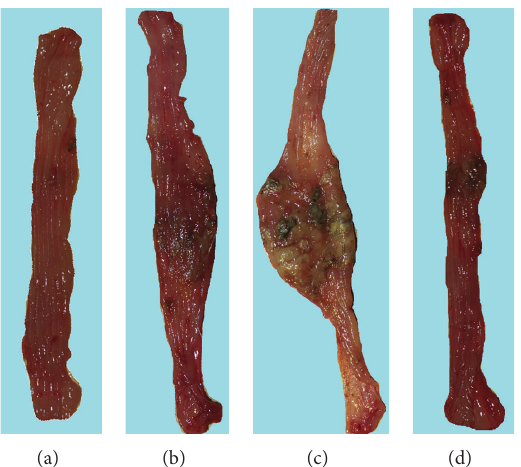
Figure 2: The representative macroscopic appearance of intact colonic mucosa (a) and the colonic mucosa of rat with TNBS colitis fed normal diet(b)orHFDwithoutexercise(c)andHFDwithexercise(d)atday14afterTNBSinduction.Note,thenormalappearanceofcolonicmucosa (a) and the severe colonic damage in TNBS rat fed normal diet (b). This damage was exacerbated in untrained rat fed HFD as reflected by necrotic damage occupying larger area of colonic mucosa (c). However, in trained rat fed HFD, the colonic damage was reduced and smaller area of the colonic damage was clearly confirmed by gross inspection (d).